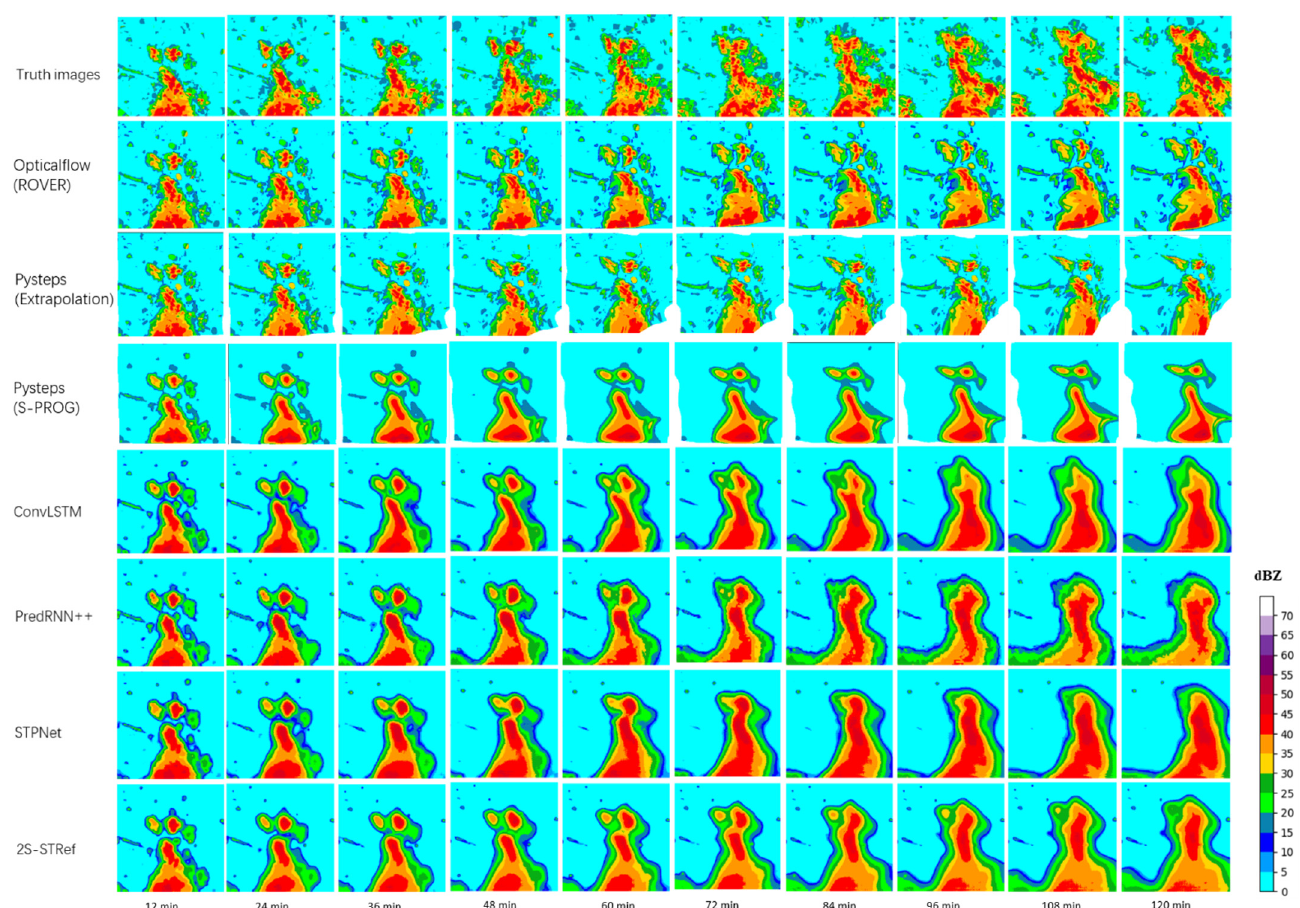
Figure 12. The visualization comparison among the evaluated methods for 12- to 120-min lead times. The radar echo images are of Southern China (around Guangzhou City) at 26 May 2019.